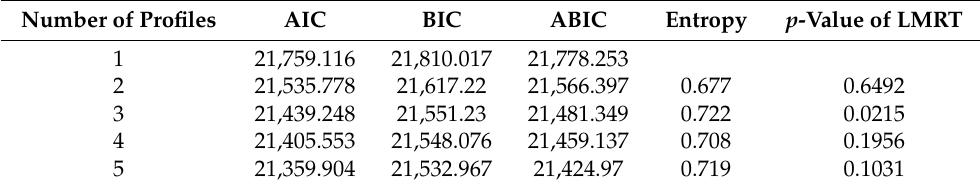
Table 3. Latent Profile Model Information Criteria, Likelihood Ratio Test, and Entropy (N = 1200). Number of Profiles AIC BIC ABIC Entropy p -Value of